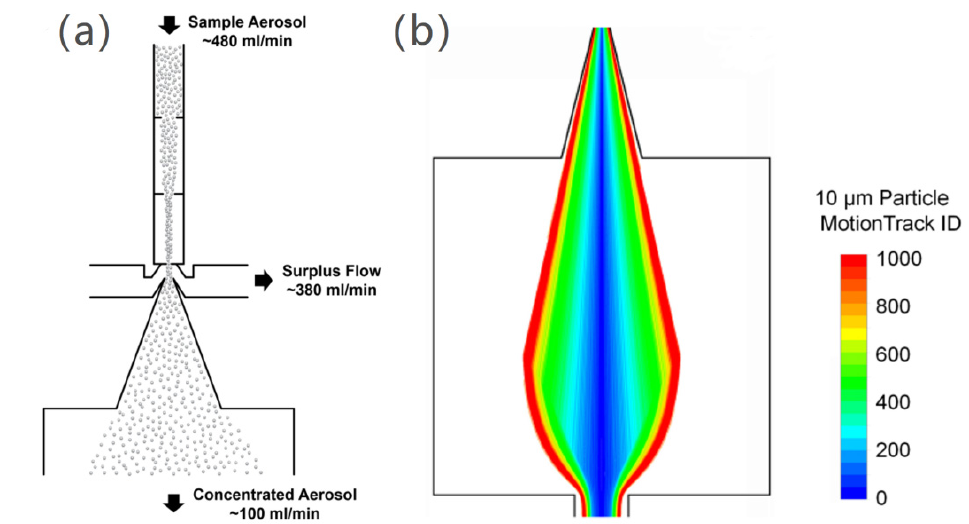
Figure 3. ( a ) Schematic diagram of the design of the virtual impactor; ( b ) Trajectory of 10 µm particles in the relaxation chamber.